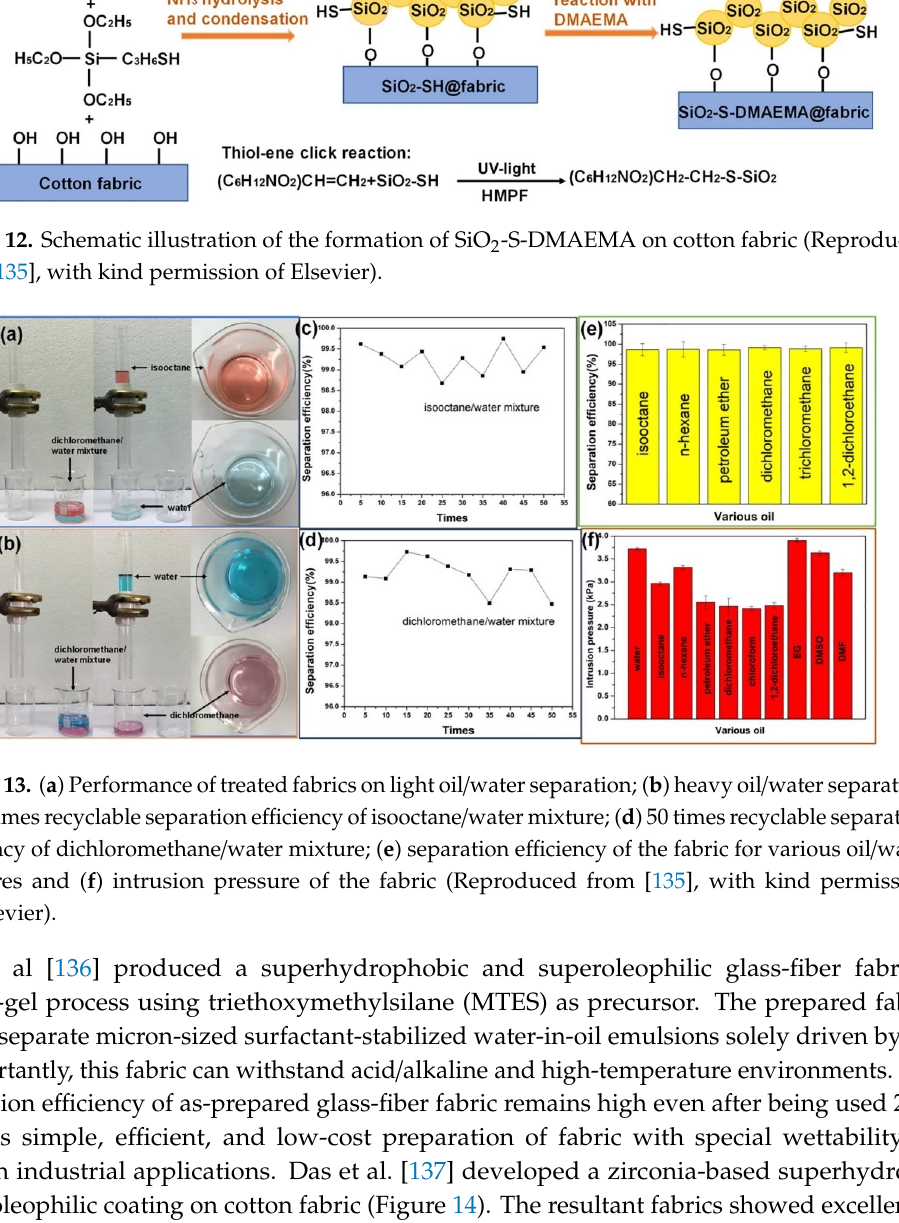
Figure 12. The treated fabric shows better oil/water separation, water-in-oil and oil-in-water emulsion separation properties, even after various harsh treatments (Figure 13).